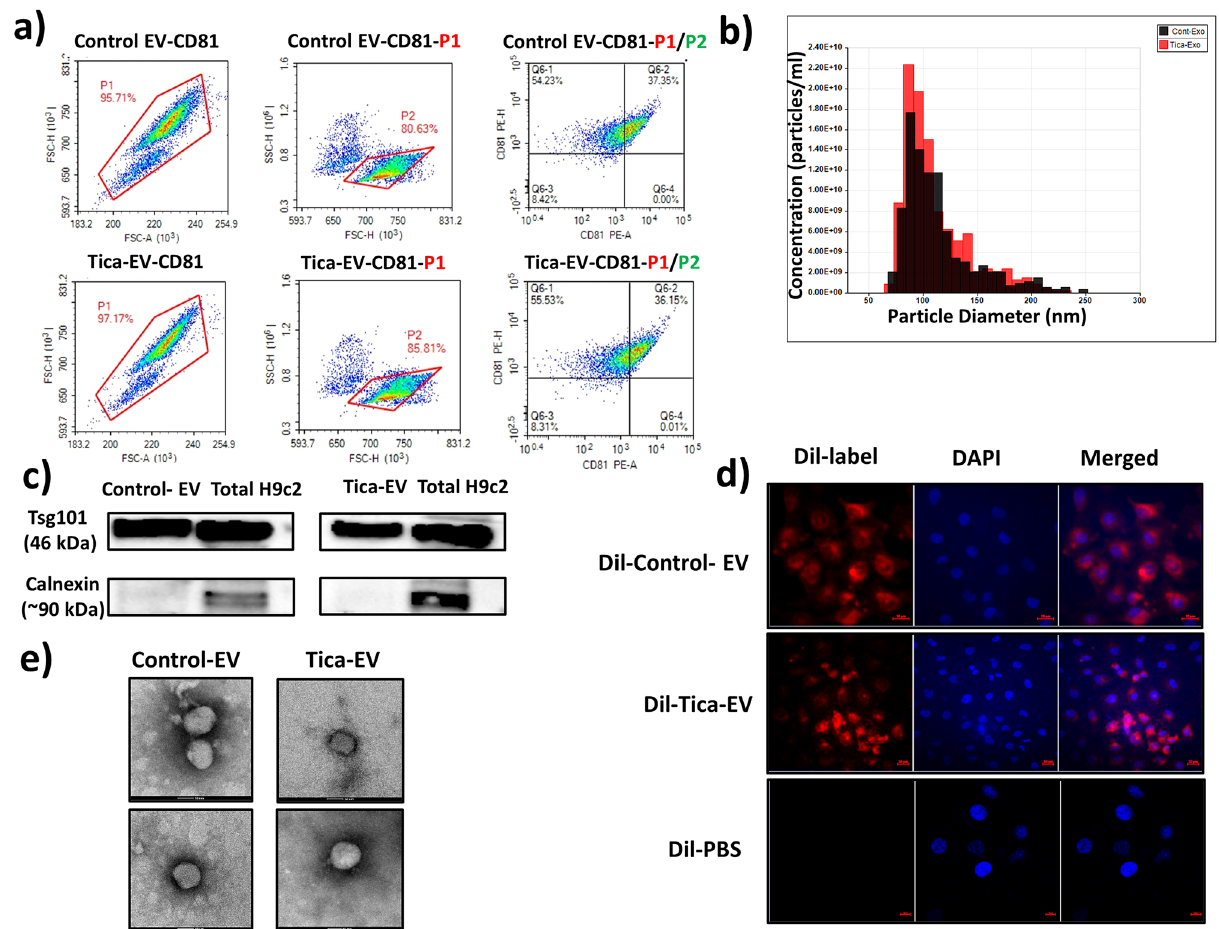
Figure 1. Characterization and quantification of isolated EVs. ( a ) Flow cytometric analysis was performed using magnetic beads coated with CD9 EV marker. These coated beads were incubated with a PE-conjugated CD81 antibody. Analaysis demonstrated as dot plot. FSC represents forward scatter and SSC represents size vs. side scatter. P1 represents gate on the doublet discrimination according to FSC-H vs FSC-A. ( b ) Size distribution and quantification of isolated extracellular vesicles were analyzed using qNanoGold. A polyurethane nanopore rated for particles < 100 Npm (NP100-, Izon Science, UK) was used. The measured mean diameter of EVS was approximately 100 nm. ( c ) Western blot was performed to detect EV proteins and cellular contaminants in isolated EVs. Tsg101 was used as EV markers and endoplasmic reticulum marker Calnexin was used as a negative control. ( d ) EVs isolated from untreated H9c2 (Dil-Control-EV) and ticagrelor treated H9c2 (Dil-Tica-EV) stained with Dil dye. The uptake of DiI-labeled EVs by H9c2 cells was visualized by confocal microscopy. The cells incubated with Dil-labelled PBS are the negative control group. ( e ) EVs isolated from control and ticagrelor treated H9c2 cells were visualized by transmission electron microscopy